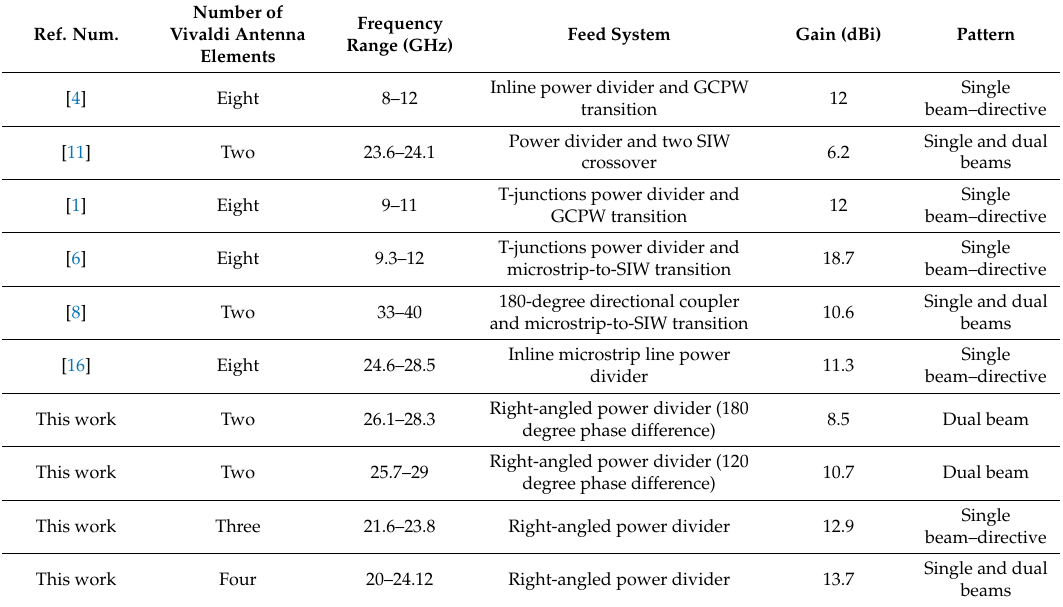
Table 4. Comparison between 10 different antenna systems using antipodal Vivaldi antennas in terms of gain, feed system, bandwidth, frequency range, and